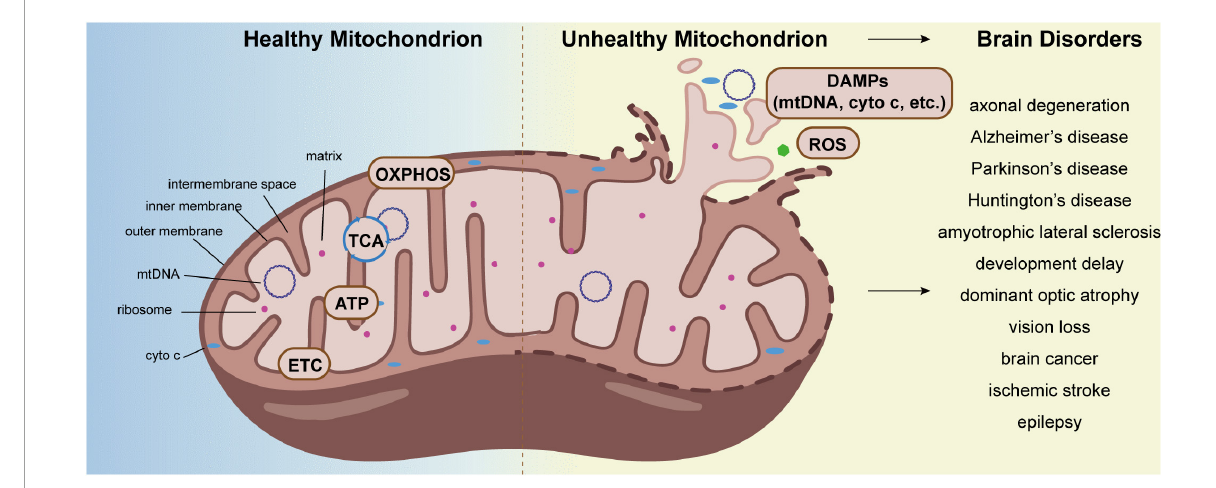
FIGURE1 Aberrant mitochondrion causes brain disorders. The tricarboxylic acid cycle (TCA cycle), oxidative phosphorylation (OXPHOS), electron transport chain (ETC), and ATP synthesis all take place primarily in mitochondria. Under stress, mitochondria produce DAMPs and excessive ROS, which cause a variety of brain disorders, including axonal degeneration, neurodegeneration diseases, dominant optic atrophy, epilepsy, and so